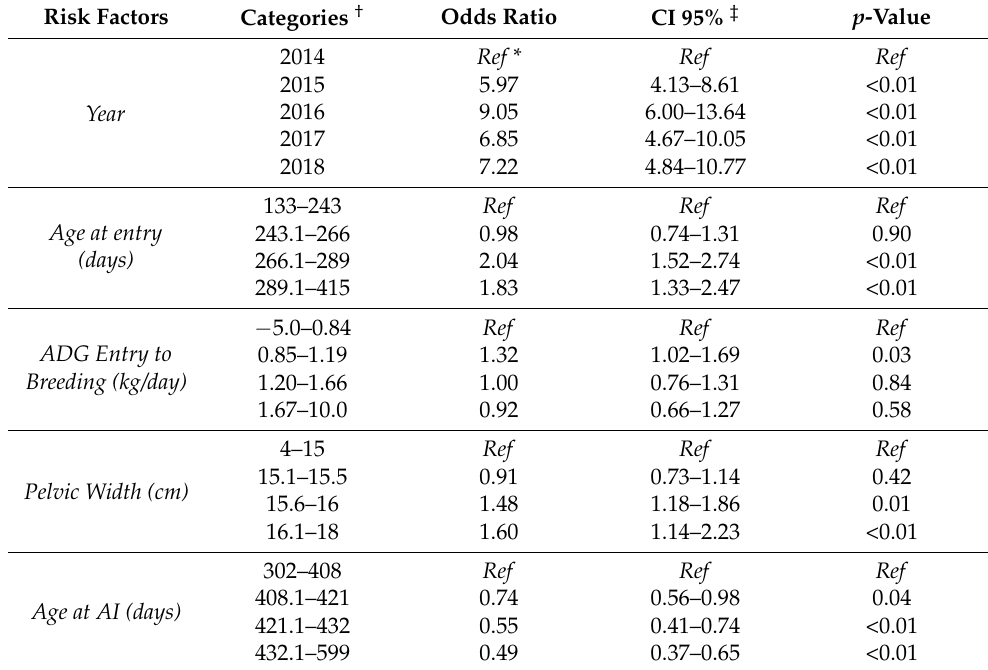
Table 2. Results of the final multivariable logistic regression model for AI.